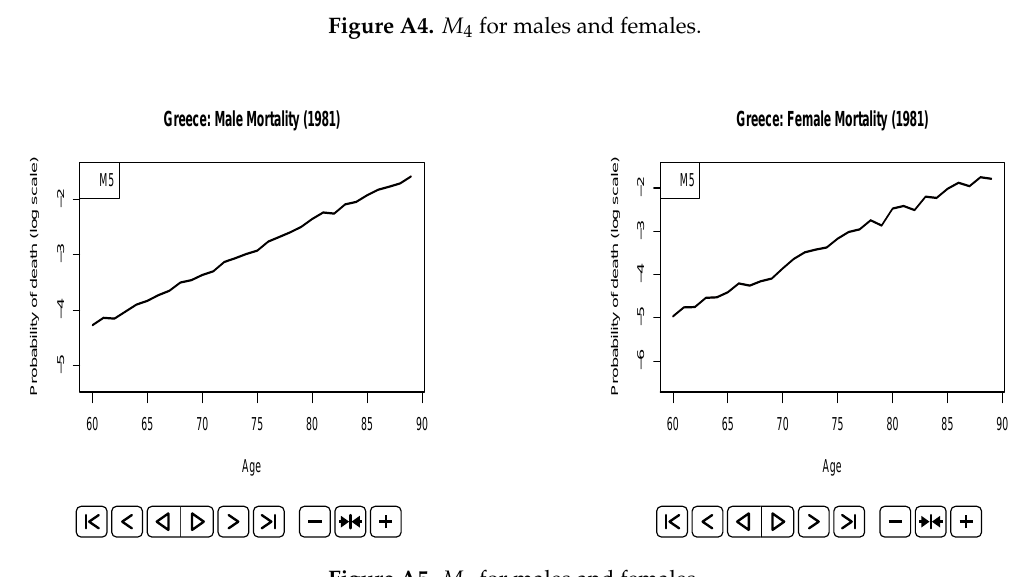
Figure A5. M 5 for males and females.